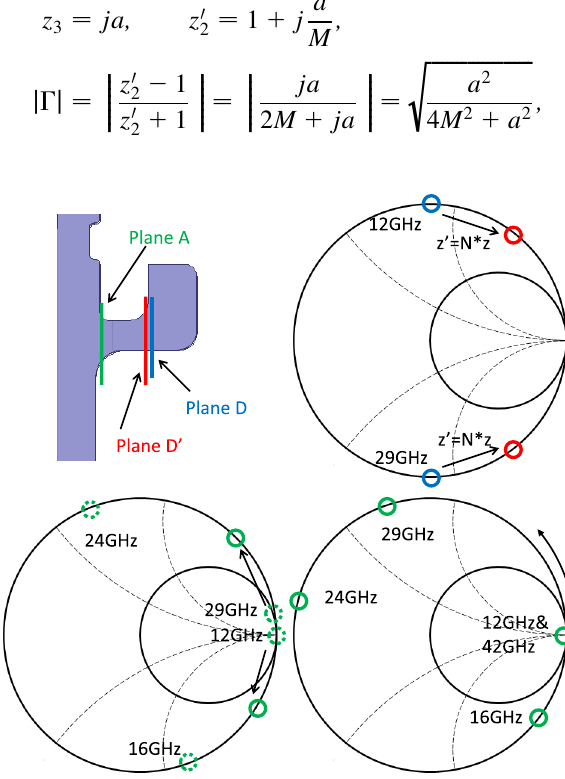
FIG. 12. Smith chart explanation for two sections choke: right top—impedance at junction of two sections; left bottom—imped- ance at termination of choke; right bottom—tune back 12 GHz. FIG. 14. Magnetic field of two dipole